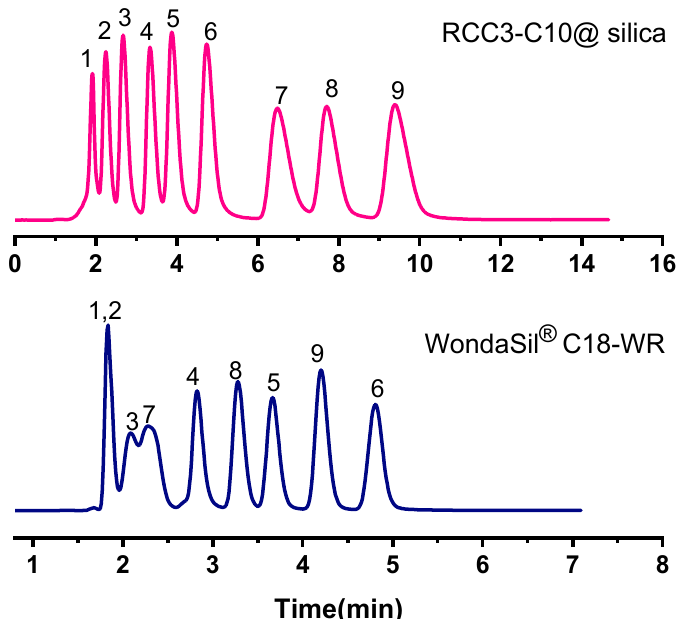
Figure 3. Chromatograms of anilines on the RCC3-C10@silica column and WondaSil ® C18-WR column. Analytes: (1) p-phenylenediamine, (2) m-phenylenediamine, (3) o-phenylenediamine, (4) aniline, (5) p-toluidine, (6) 3, 4-dimethylamine, (7) 4, 4-biphenylenediamine, (8) m-nitroaniline, (9) o-nitroaniline. Mobile phase: 60% methanol/water ( v / v ); Flow rate: 1.0 mL/min; UV: 254 nm.